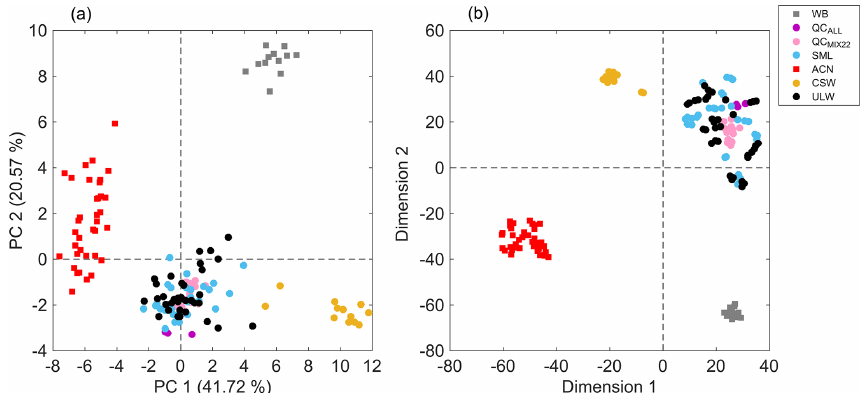
Figure 2. (a) PCA score plot showing the first two principal components, and a (b) bidimensional t-SNE plot of seawater samples (circles) with solvent blanks (squares). The plot can be read by using the following: WB – sample preparation blanks using ultrapure water (gray); QC ALL – pooled sample from all seawater samples before lyophilization (purple); QC MIX22 – pooled sample from all reconstituted seawater samples (pink); SML – sea surface microlayer water samples (light blue); ACN – acetonitrile (red); CSW – commercial seawater samples (gold); and ULW – underlying water samples (black). PCA and t-SNE models were built using the 51 extracted features and all replicates were